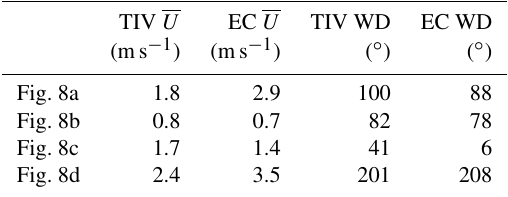
Table 3. Mean wind parameters for the cases in Fig.